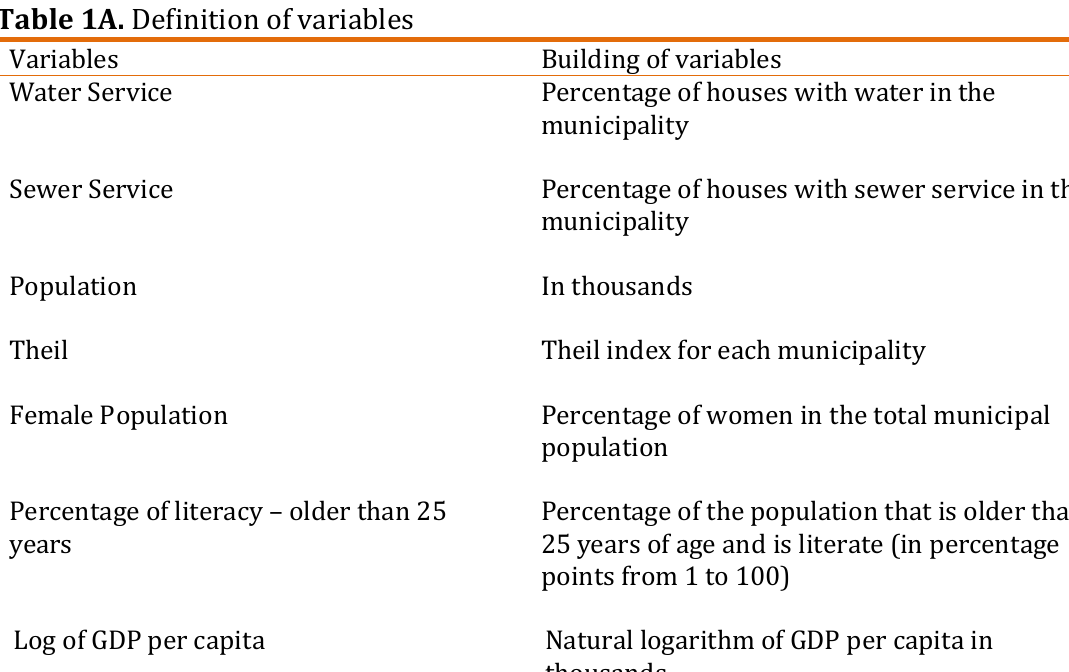
Table 1A. Definition of variables